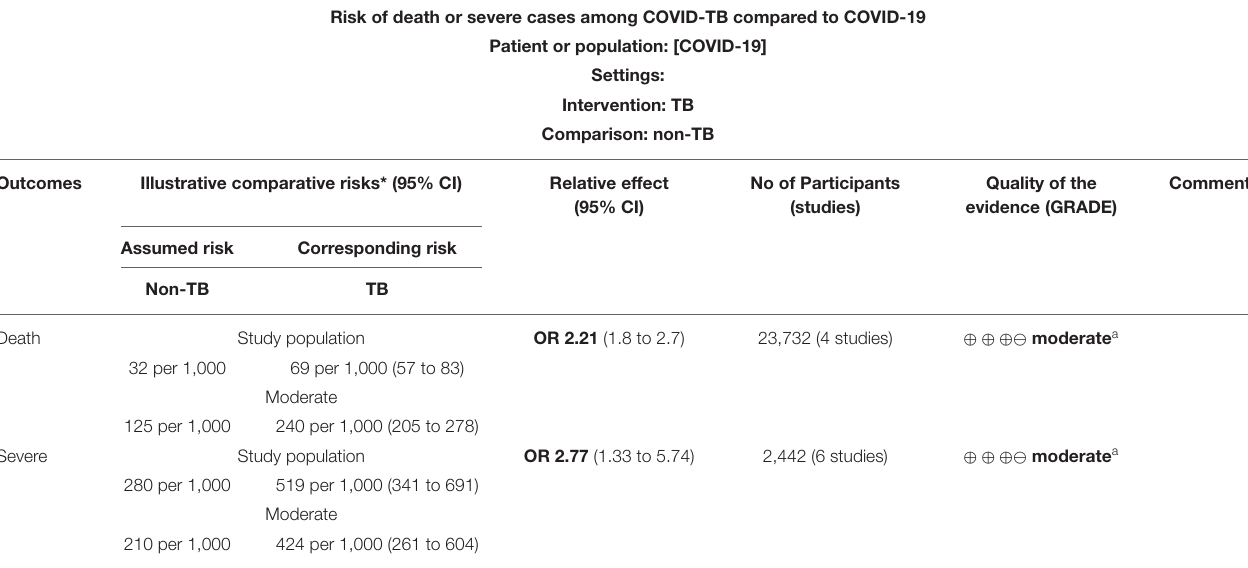
TABLE 3 | GRADEpro assessment of methodologic quality of included studies examining the ability of TB to increase the risk of death or severe cases among COVID-19. Risk of death or severe cases among COVID-TB compared to